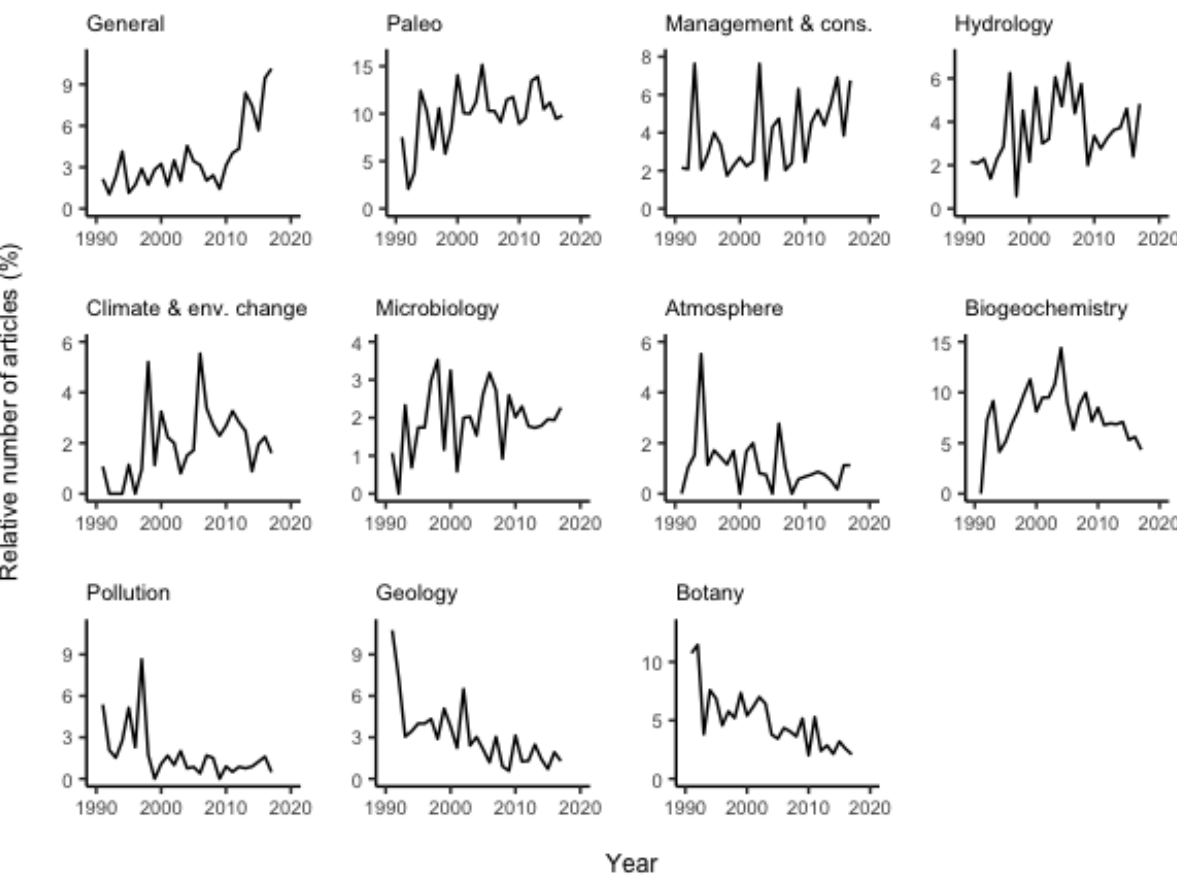
Figure 2. Trends in journal disciplines, relative to the total number of articles per year. Vertical axes differ among journals.